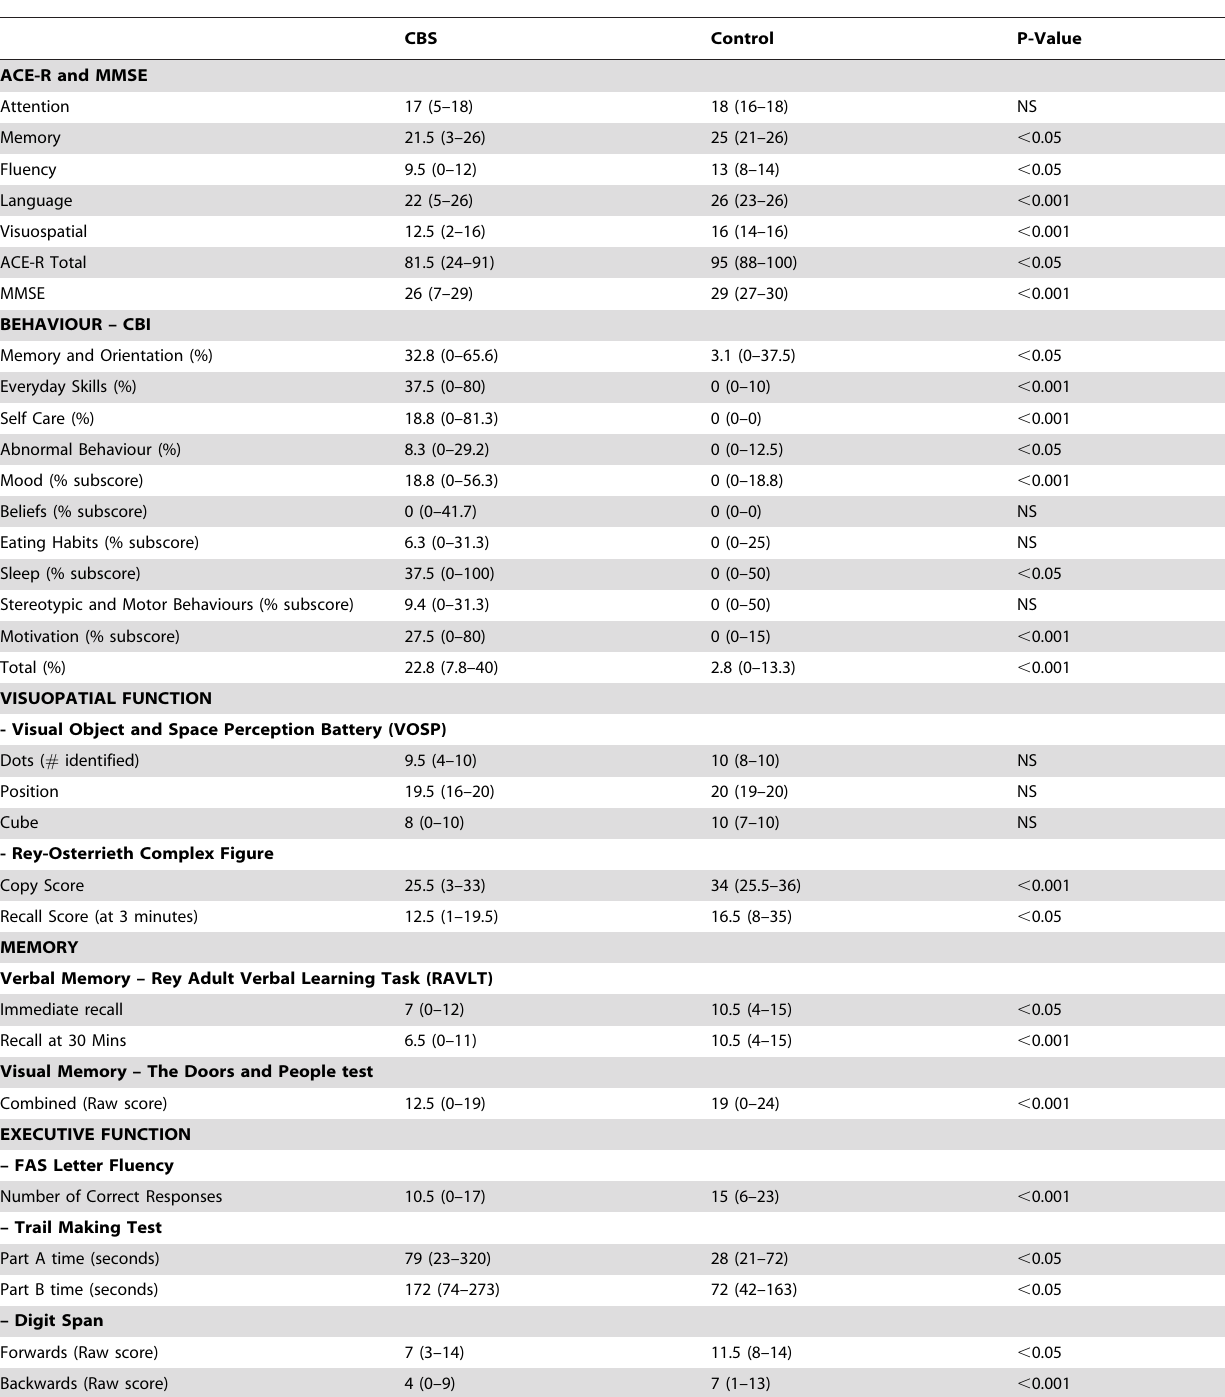
Table 2. Neuropsychological performance of CBS patients compared to